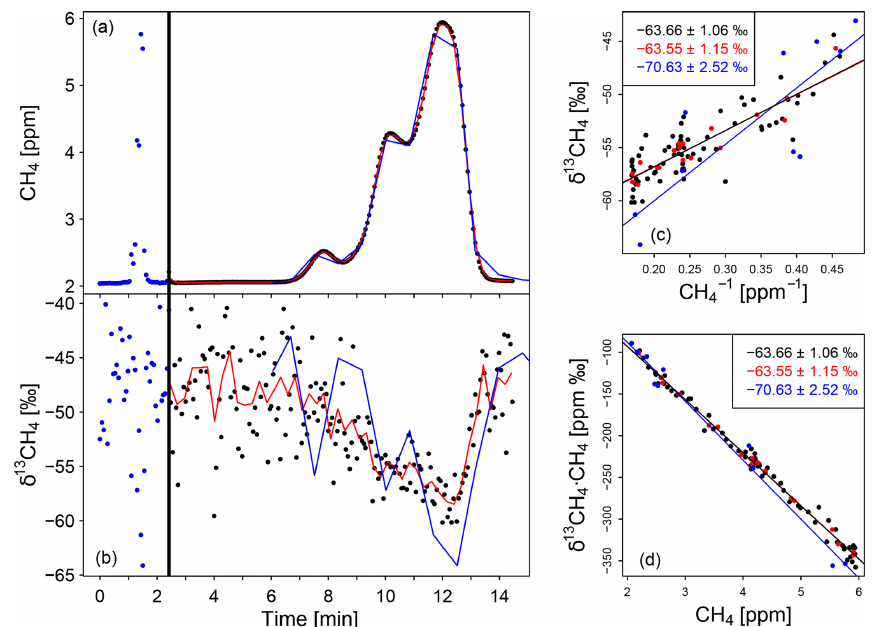
Figure 2. Measurement of a typical plume passing a biogas plant as well as a Keeling plot and a Miller–Tans plot to calculate the δ 13 CH 4 signature of the biogas plant. (a, b) Typical CH 4 and δ 13 CH 4 peaks in the biogas plant plume. The vertical black line shows the switch from monitoring to replay mode. The red data are 15s average and the blue line is the in situ peak (first peak) stretched by a factor of 12.5. (c) Keeling plot (c) and Miller–Tans plot (d) to calculate the δ 13 CH 4 source signature (insets). The blue colour represents the monitoring mode, the black and red (15s mean) ones the replay mode. For better visibility the error bars are not